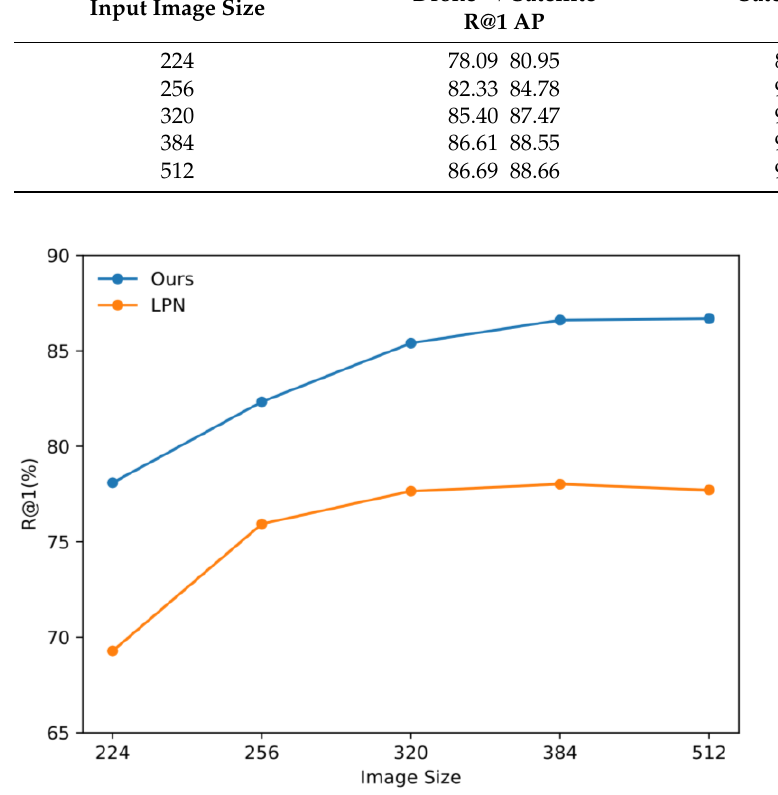
Figure 8. Effect of input size of images.